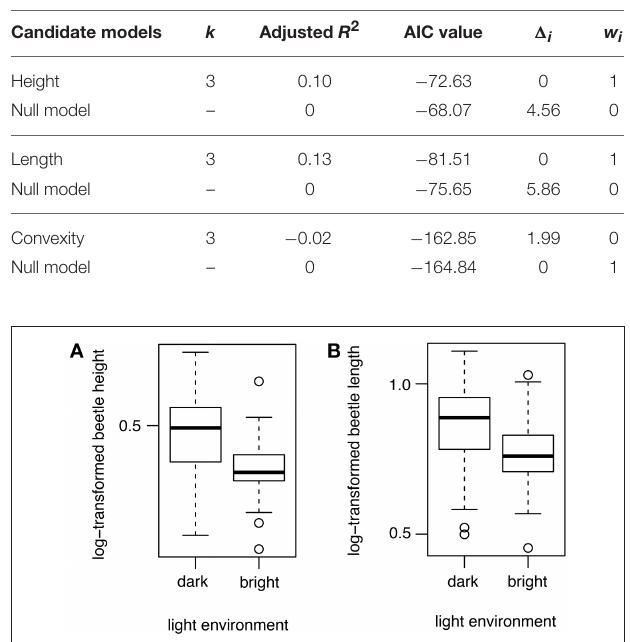
TABLE 2 | Effect of light environment on beetle morphology.